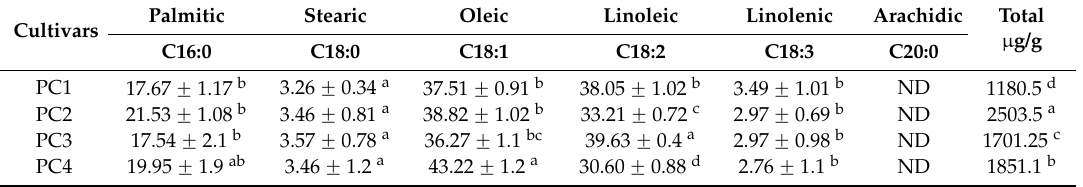
Table 4. Fatty acid composition of persimmon cultivar seeds, expressed as % of total fatty acids.